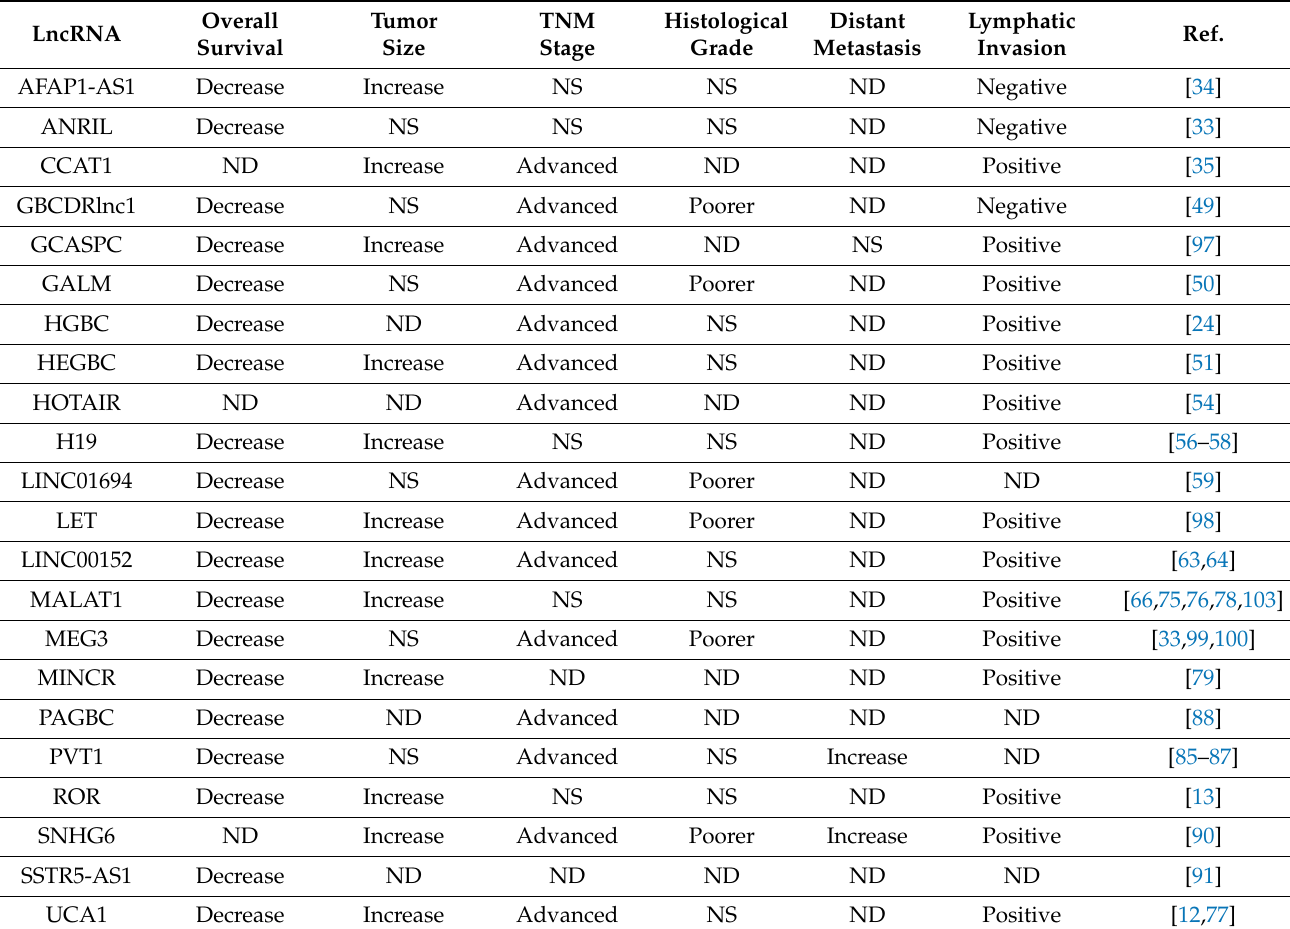
Table 2. Resume of lncRNAs expression related with clinicopathological features on Gallbladder